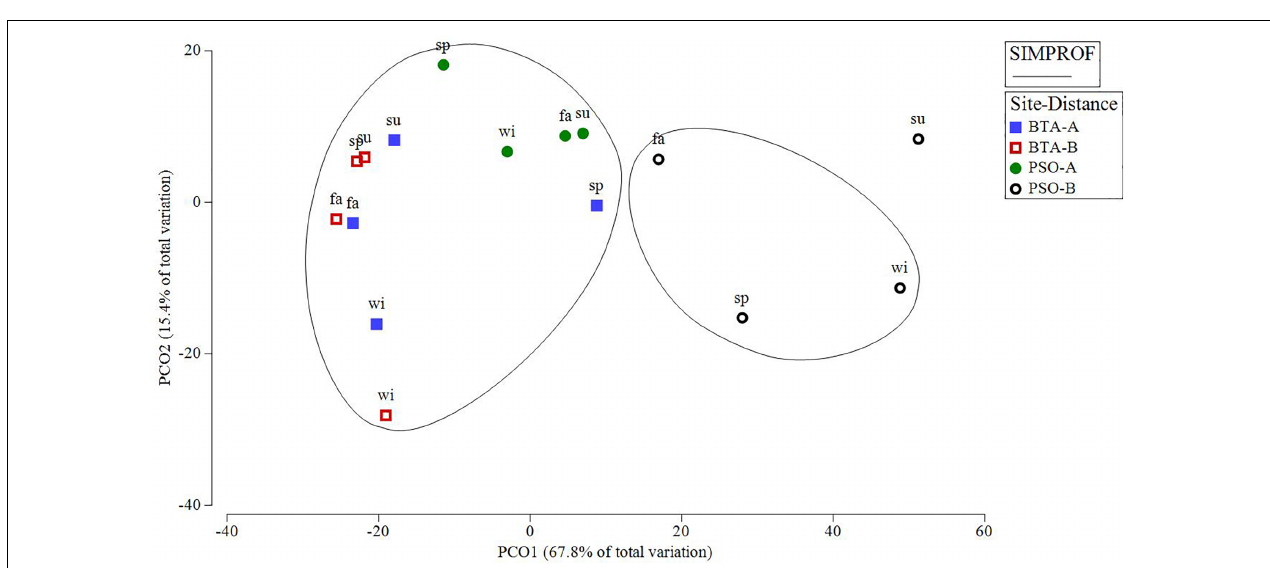
Bold p-values represent significance.